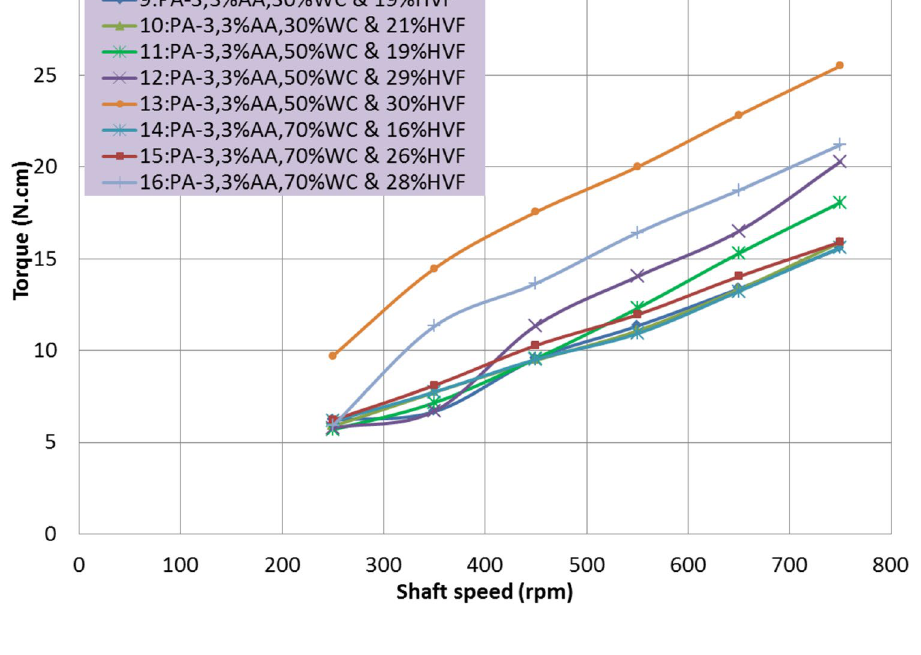
Fig. 16 In situ viscosity of hydrate slurries formed from PA-3-water systems. AA anti- agglomerant, WC watercut, HVF hydrate volume